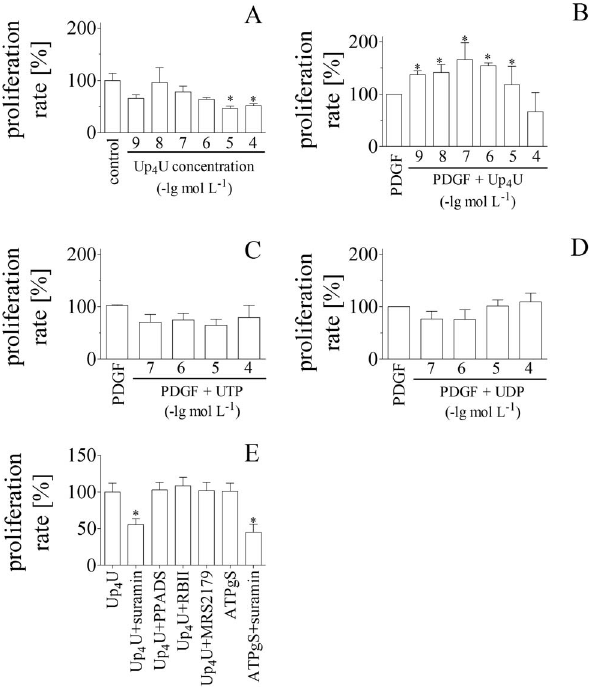
Figure 2. ( A )Effect of increasing Up 4 U concentrations on proliferation rate of vascular smooth muscle cells in the absence of PDGF (n=6). ( B )Effect of increasing Up 4 U concentrations on proliferation rate of vascular smooth muscle cells in the presence of PDGF (10 2 6 mol L -1 PDGF each; n=3). ( C )Effect of increasing UTP concentrations on proliferation rate of vascular smooth muscle cells in the presence of PDGF (10 2 6 mol L -1 PDGF each; n=3). ( D )Effect of increasing UDP concentrations on proliferation rate of vascular smooth muscle cells in the presence of PDGF (10 2 6 mol L -1 PDGF each; n=3). ( E )Effect of Up 4 U (10 2 7 mol L -1 ) or ATP c S (10 2 7 mol L -1 ) in the presence of PDGF (10 2 6 mol L -1 PDGF each; n=3) and suramin (10 2 4 mol L -1 ), PPADS (10 2 5 mol L -1 ), MRS2179 (10 2 5 mol L -1 ) or RBII (10 2 5 mol L -1 ) on proliferation rate of vascular smooth muscle cells.